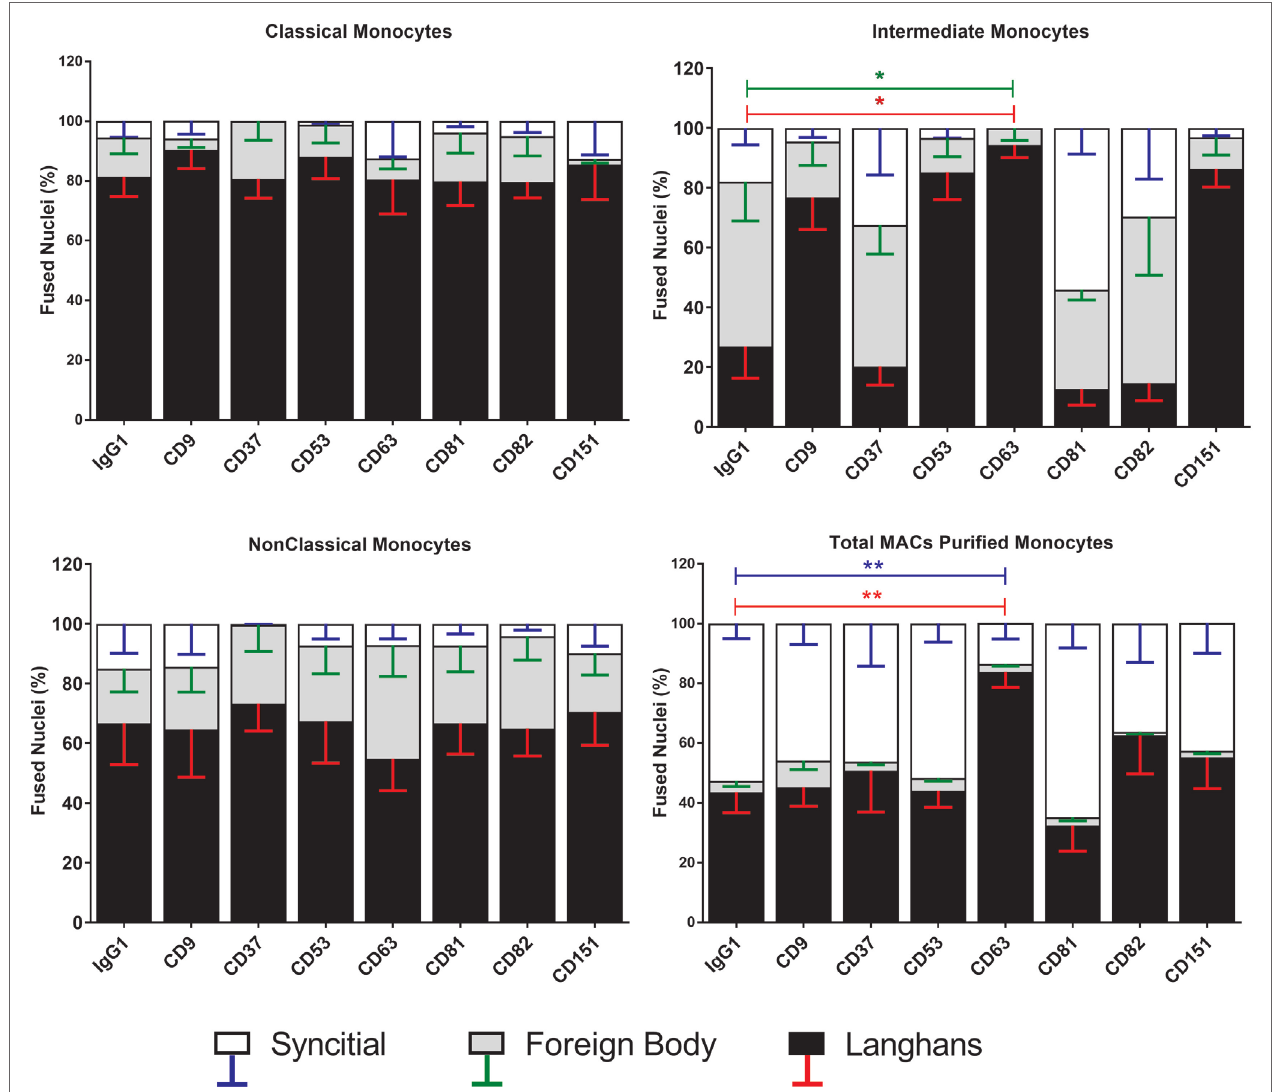
FigUre 7 | Anti­CD63 antibodies can modulate giant cell morphology only in the intermediate monocyte subset. Purified monocyte subsets were cultured in media containing concanavalin A (ConA) and either an anti­tetraspanin antibody or IgG1 control at 10 µg ml − 1 for 72 h. Nuclei counted inside each monocyte­derived giant cell (MGC) were ascribed to one of the giant cell types and presented as a percentage of the fused nuclei counted. Bars represent means ± SEM, n = 3–8, tested with a Kruskal–Wallis test with Dunn’s multiple comparisons tests comparing the same MGC types between the anti­tetraspanin conditions and the IgG1 control. Black bars/red error bars: Langhans giant cell, gray bars/green error bars: foreign body giant cell and white bars/blue error bars: